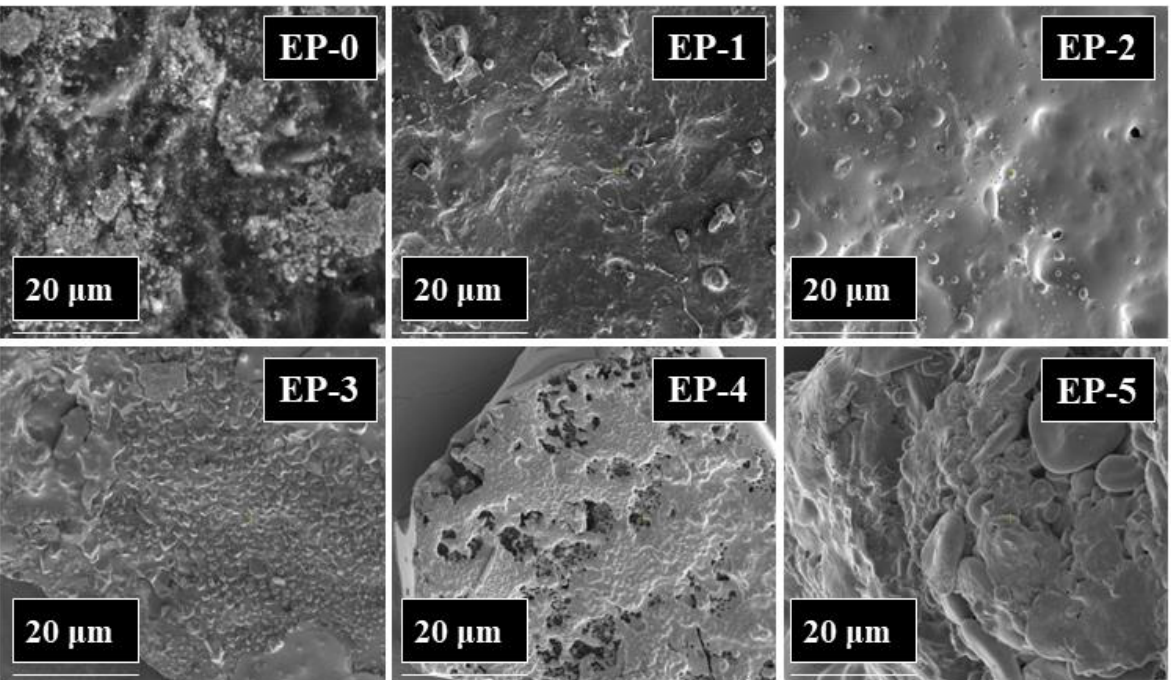
Figure 9. SEM micrographs of epoxy composites heated up to 800 °C, with the heating rate of 10 °C/min, under nitrogen atmosphere.